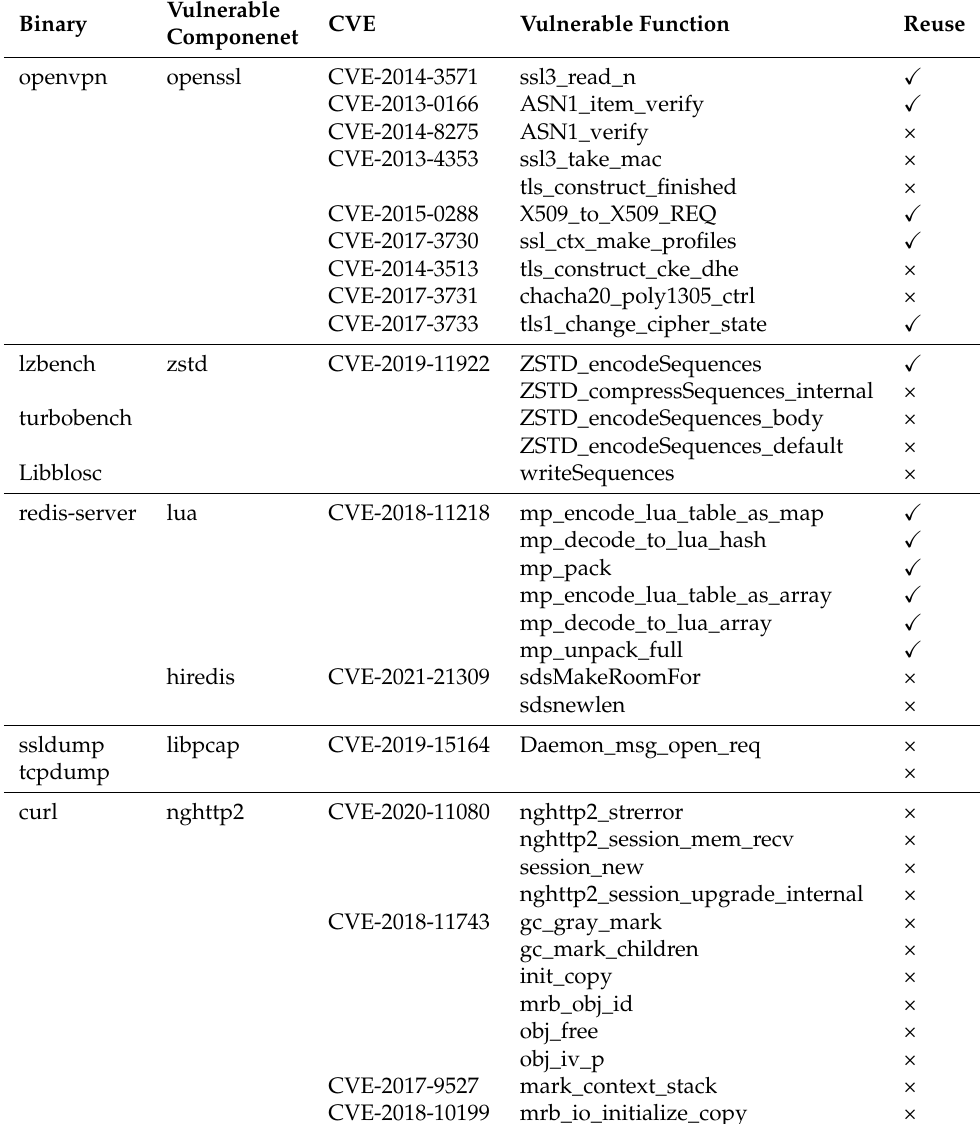
Table 7. Open-source vulnerability function detection